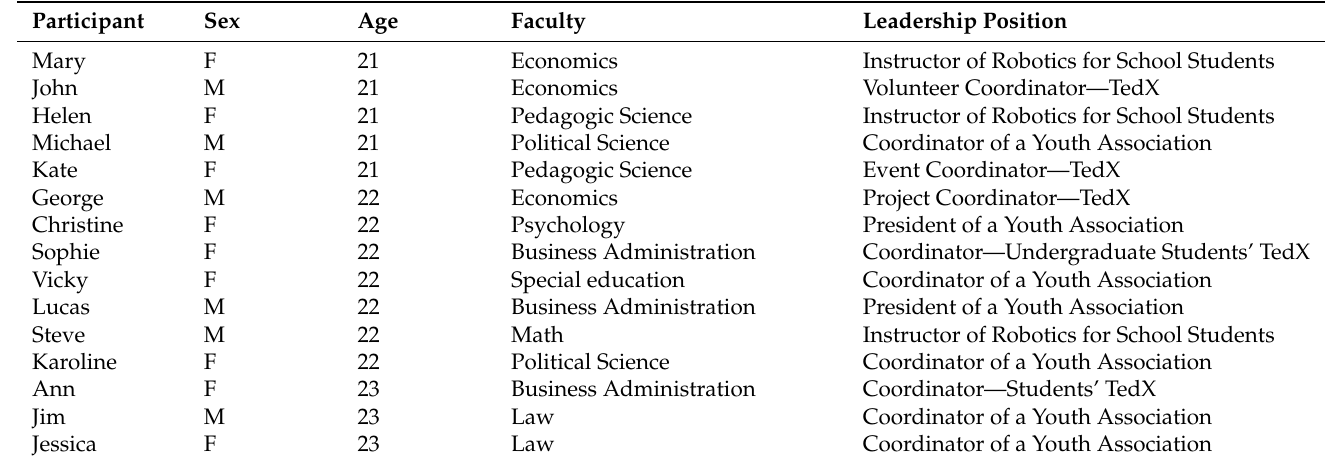
Table 1. Information about the